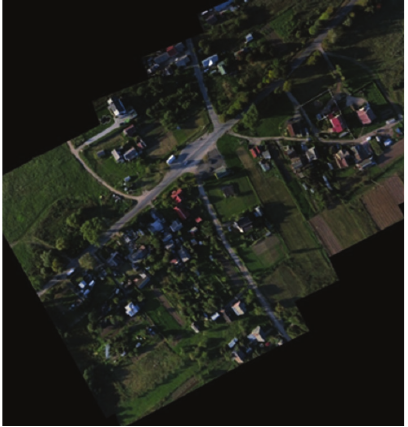
Figure 7: Orthophoto image of the